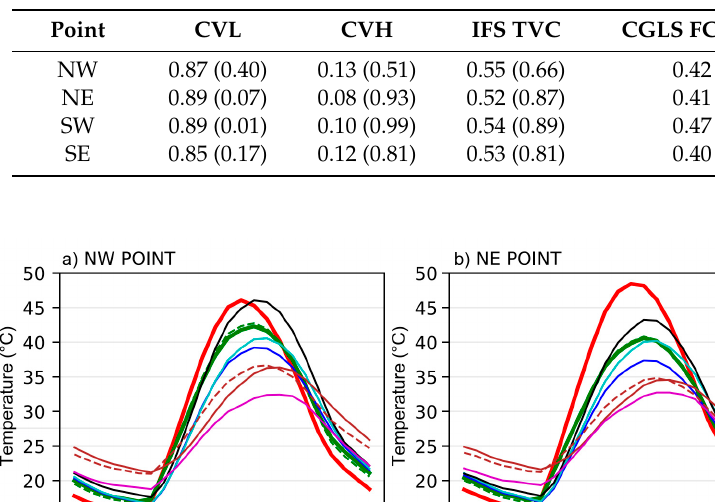
Table 3. Revised and original (between brackets) vegetation parameters in in the four points domain in Southern Portugal. CVL and CVH identify the low and high vegetation grid fraction, IFS TVC is the derived Total Vegetation cover (using the cveg in Table 1 and Equation (1)) and the CGLS FCover the fraction of green vegetation from the Copernicus Global Land Service.